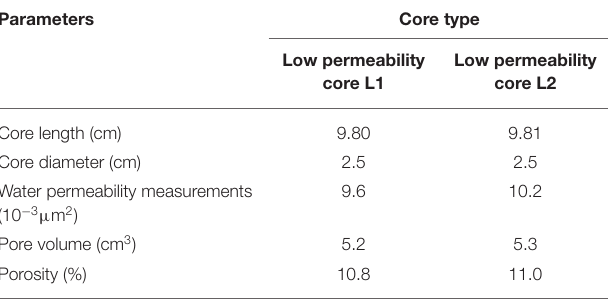
TABLE 1 | 10 10 − 3 µ m 2 Core parameters. ×